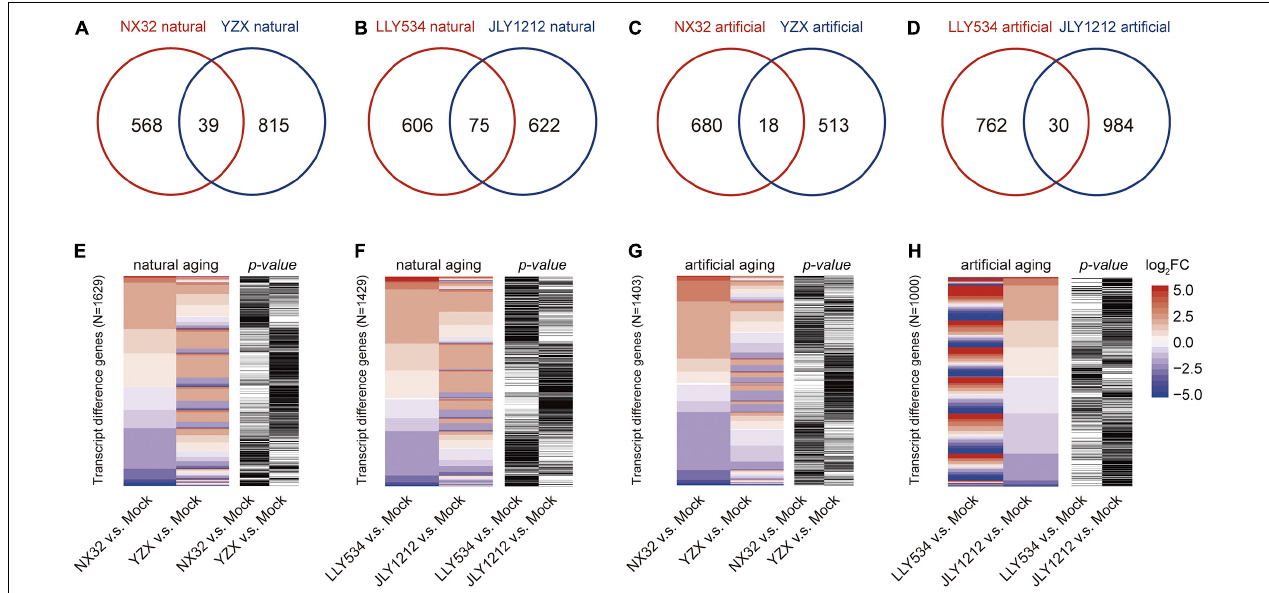
FIGURE 4 | Comparison of significantly differentially expressed genes between four rice varieties with natural and artificial aging. (A,B) Venn diagram depicting the overlap of significant transcript differences (| log 2 FC| > 1 and p < 0.05) between NX32 and YZX (A) and between LLY534 and JLY1212 (B) under natural aging conditions. (C,D) Venn diagram depicting the overlap of significant transcript differences (| log 2 FC| > 1 and p < 0.05) between NX32 and YZX (C) and between LLY534 and JLY1212 (D) under artificial aging conditions. (E,F) Heatmap of differentially expressed genes in conventional varieties NX32 and YZX (E) and in hybrid varieties JLY1212 and LLY534 (F) when comparing natural aging with mock aging. Blue–red represents mRNA expression levels, and black–white represents the p -value of the expression level of the transcripts. If the p -value is less than 0.05, it is black; otherwise, it is white. (G,H) Heatmap of differentially expressed genes in conventional varieties NX32 and YZX (G) and in hybrid varieties JLY1212 and LLY534 (H) when comparing artificial aging with mock aging. Blue–red represents mRNA expression levels, and black–white represents the p -value of the expression level of the transcripts. If the p -value is less than 0.05, it is black; otherwise, it is